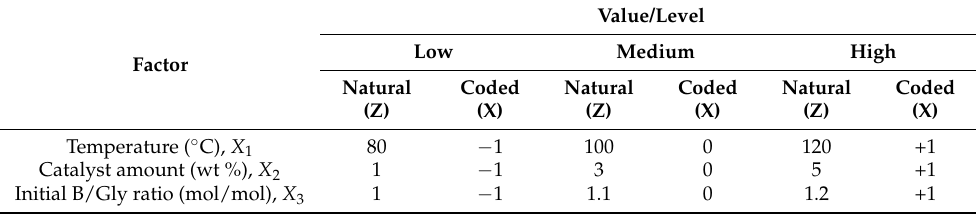
Table 6. Natural and coded values of the independent variables in the experimental design.